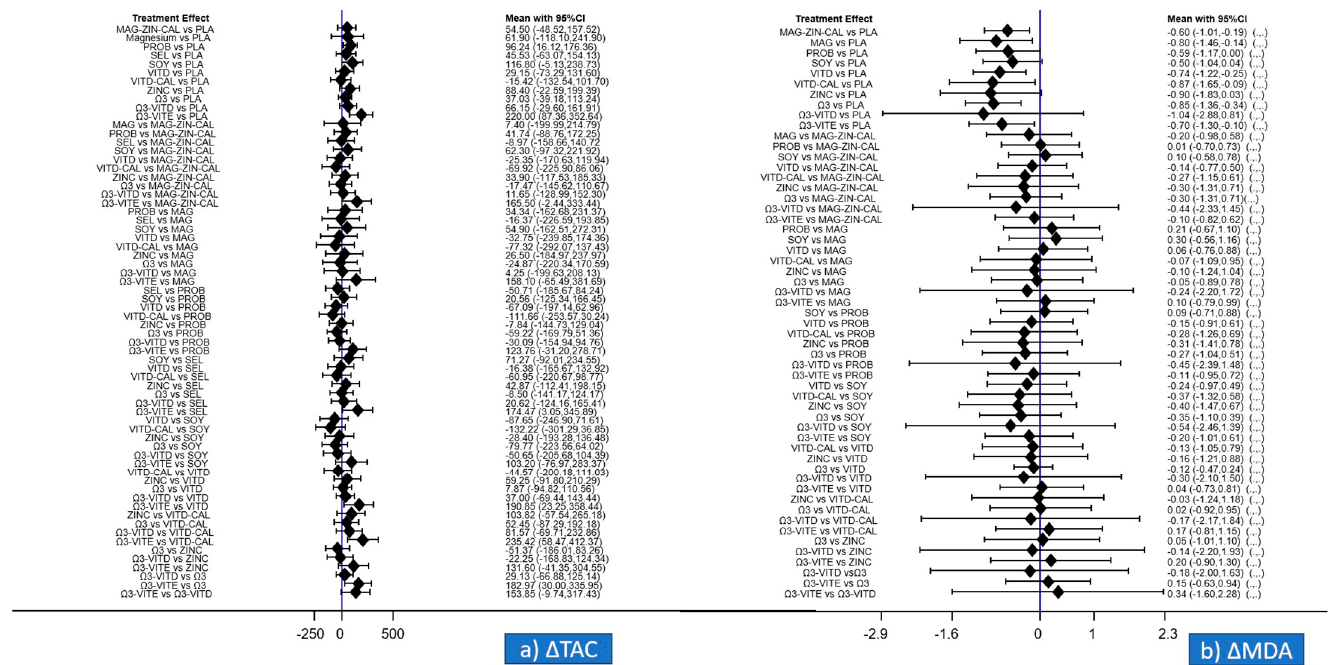
Figure 3. Mean difference (MD) for ( a ) ∆ TAC (changes in total antioxidant capacity) and ( b ) ∆ MDA (changes in malondi- aldehyde) as estimated from the network meta-analysis for every possible pair of interventions. Solid lines represent 95% Confidence Intervals (CIs). Table 3. Direct and indirect (in grey) estimates of the mean differences of ∆ TAC. Each column presents a different